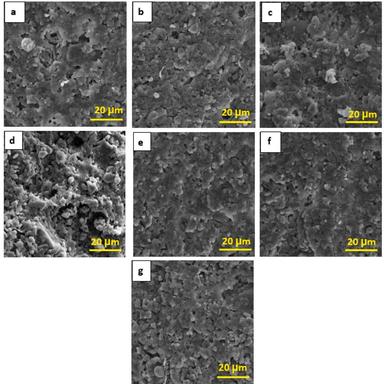
FE-SEM images of the inner surface of tubular ceramic membranes: a) M-Z, b) M-Z-PS10, c) M-Z-PS20, d) M-Z-PS30, e) M-Z-BFS10, f) M-Z-BFS20, g) M-Z-BFS30.